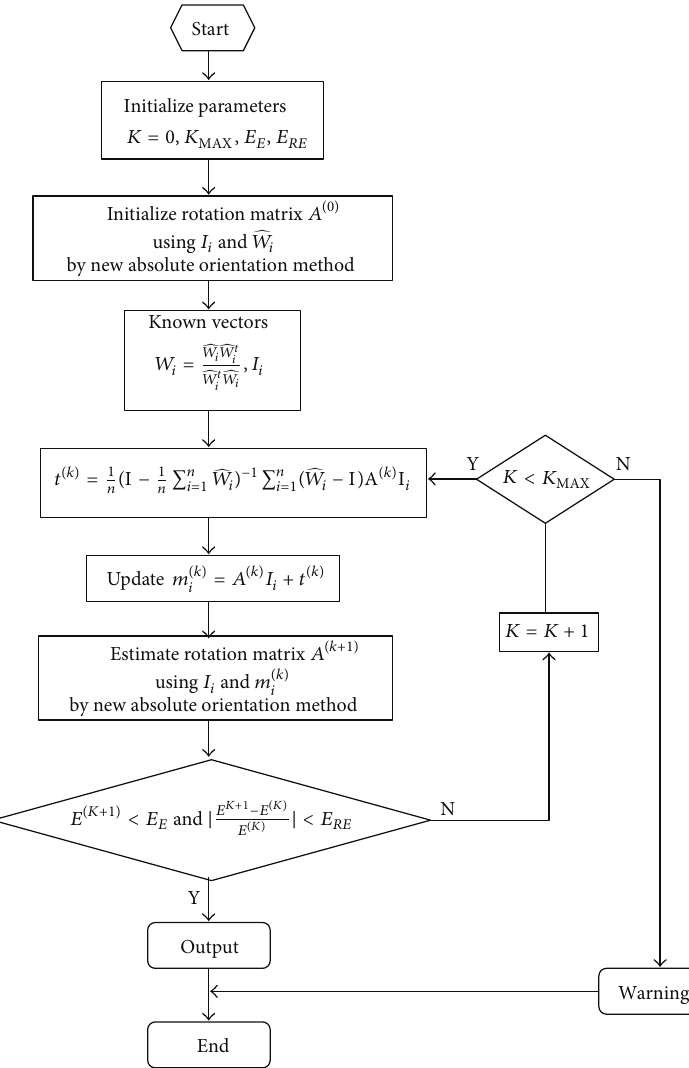
F 2: Flow chart of the